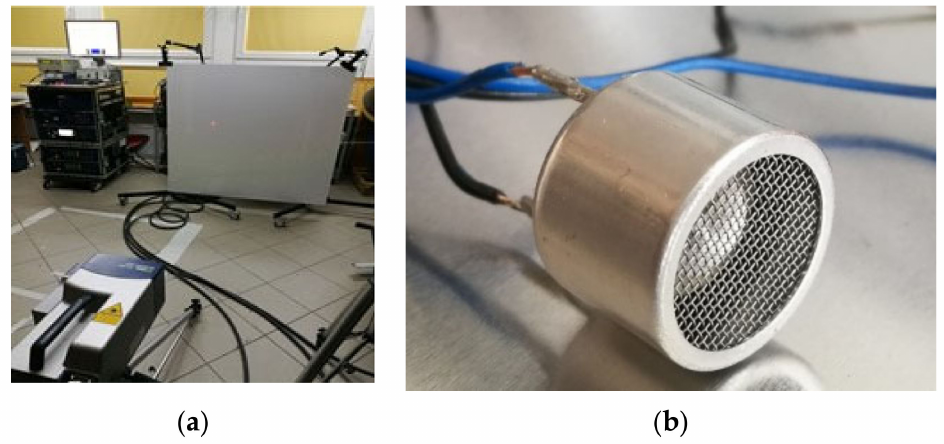
Figure 4. View of the measurement setup: ( a ) whole setup, ( b ) air-coupled